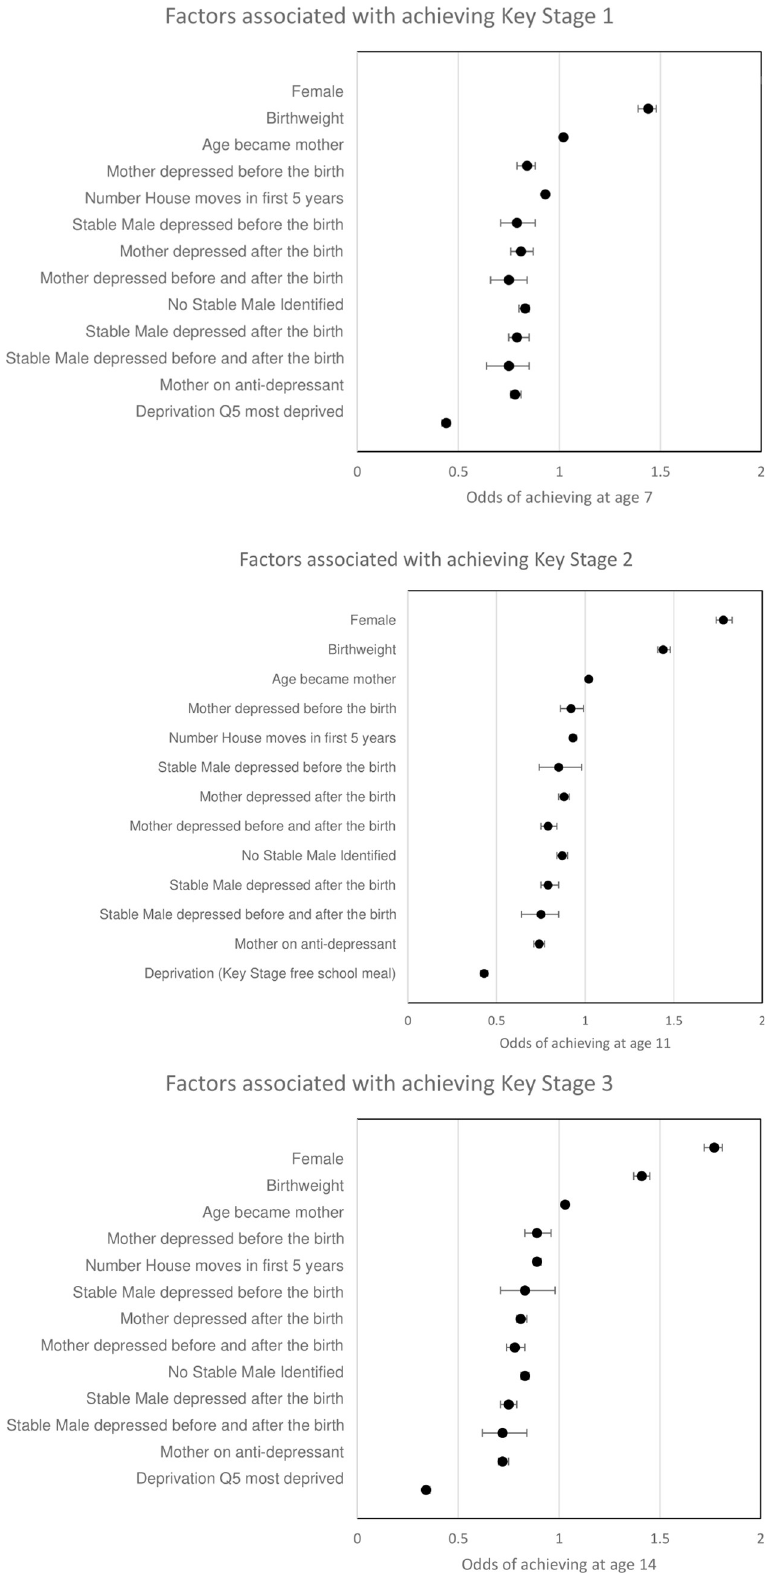
Fig 2. Logistic regression of all factors associated with achieving educational milestones at (a) Key stage 1 (age 7), (b) key stage 2 (age 11) and (c) key stage 3 (age 14). Note: Quintile Q5 most deprived and Q1 least deprived. https://doi.org/10.1371/journal.pone.0258966.g002 PLOS ONE | https://doi.org/10.1371/journal.pone.0258966 November17,